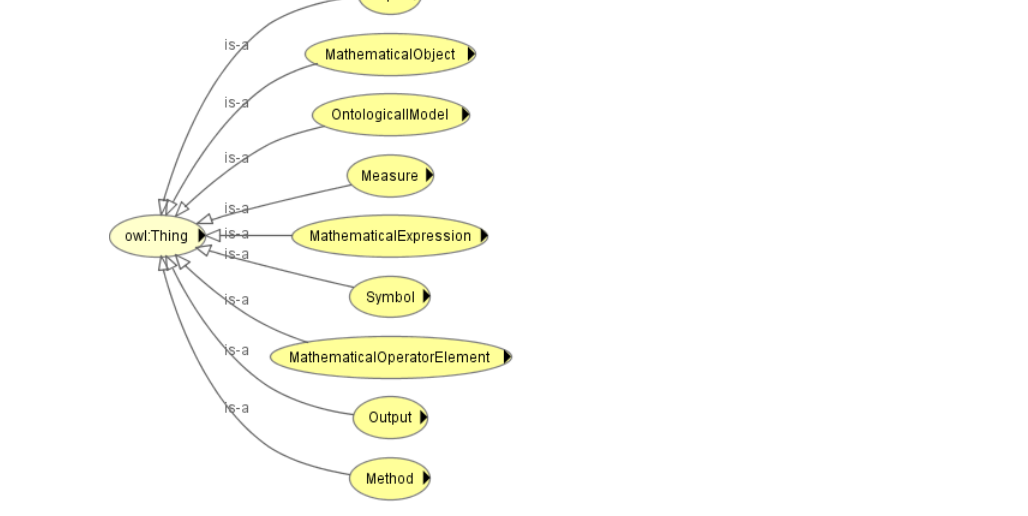
Figure 10. First taxonomical layer representation of the Mathematical Modeling Ontology classes.